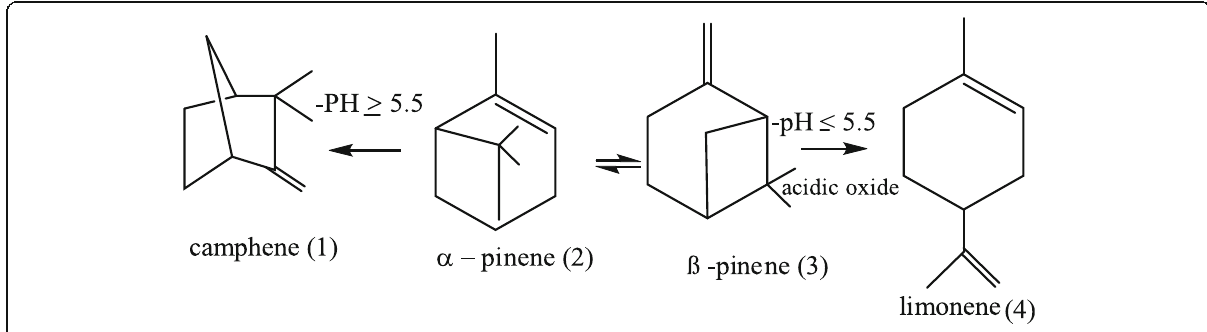
Fig. 4 Chemical transformation of some secondary